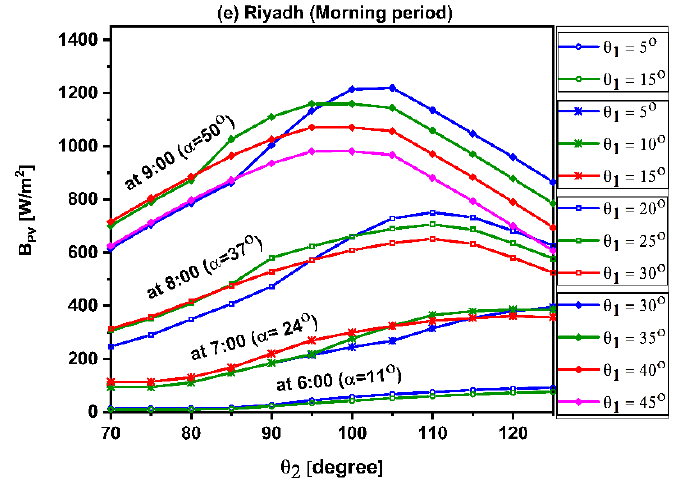
Figure 5. The irradiance B PV at different inclination angles in the case of double coverage for the solar time from sunrise to 9:00 for the selected cities.